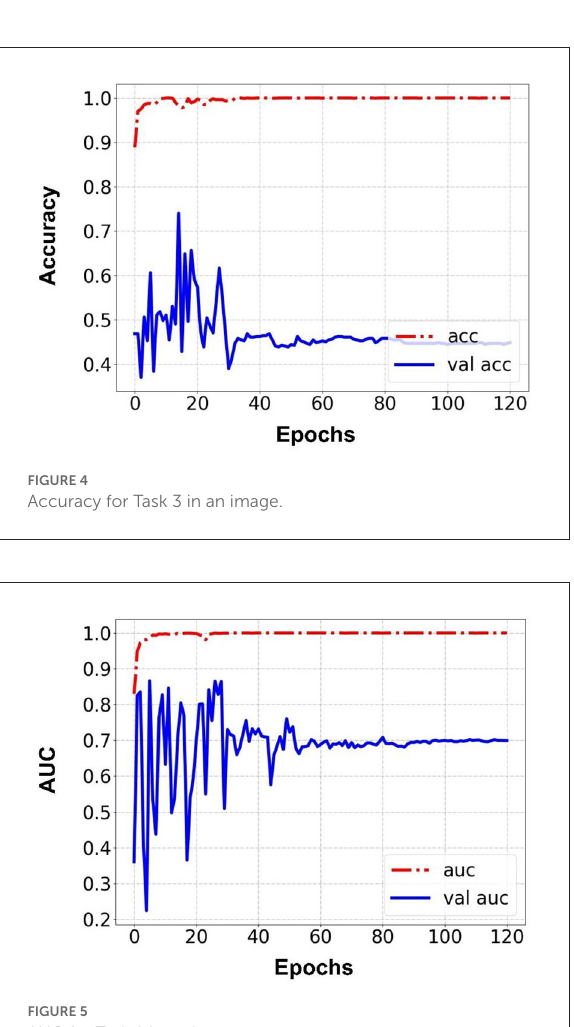
FIGURE7 AUC for Task 3 in an